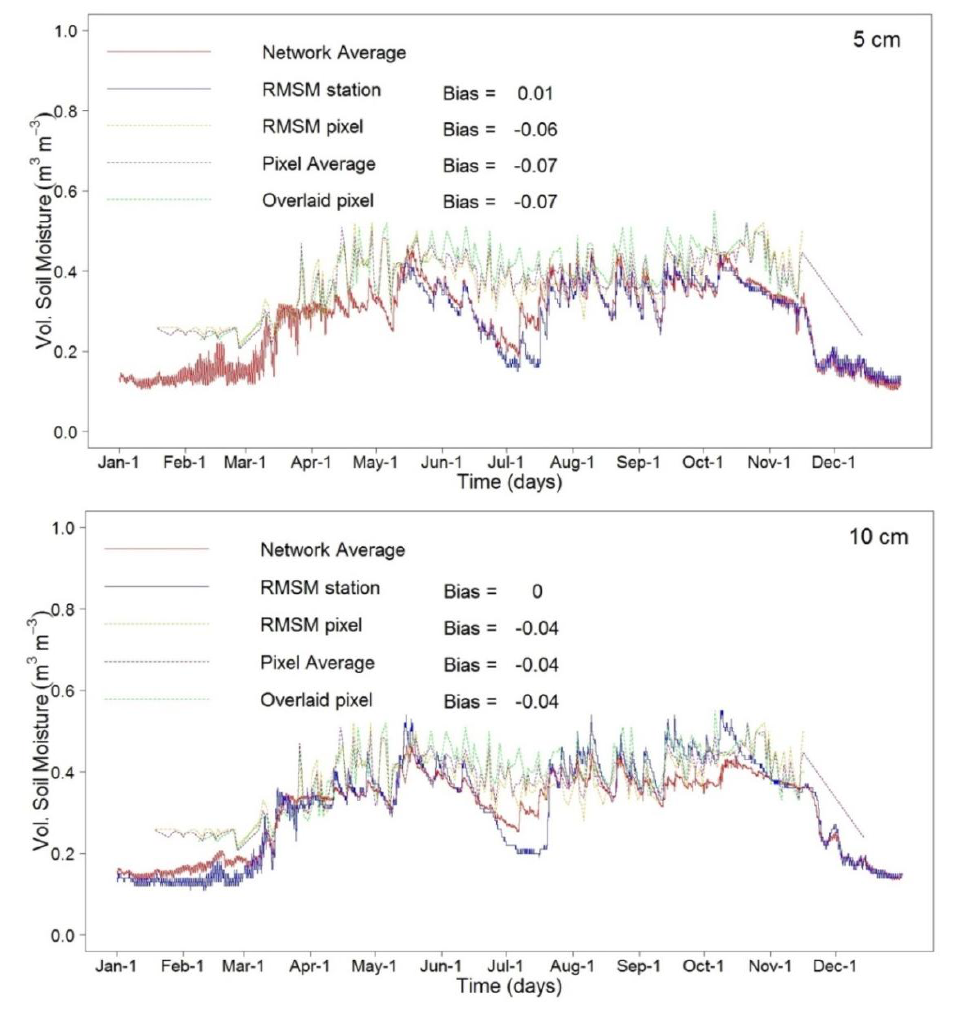
Figure 9. Time series comparison of soil moisture observation from network average ( i.e. , the bench mark) to the RMSM station, RMSM pixel, pixel average and the satellite pixel that overlays the RMSM